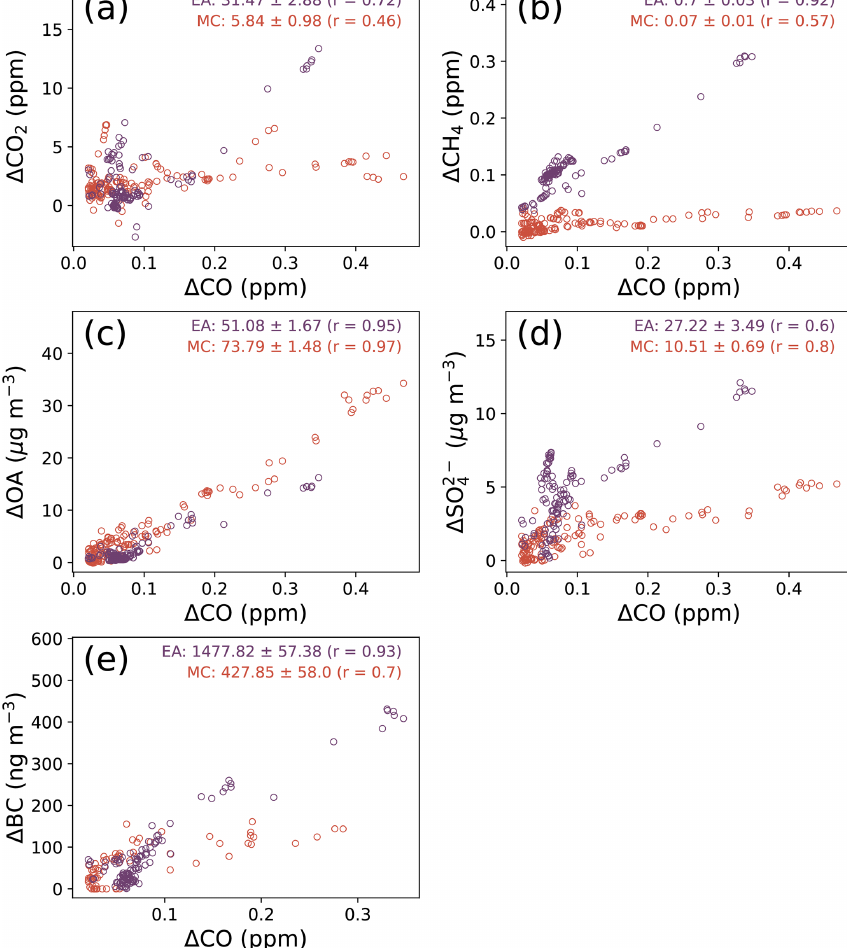
Figure 7. Linear regressions of (a) (cid:49) CO 2 /(cid:49) CO, (b) (cid:49) CH 4 /(cid:49) CO, (c) (cid:49) OA /(cid:49) CO, (d) (cid:49) SO 2 − Continent (MC; red) and East Asia (EA; purple). Annotated are species ratios (slope) per region and standard error (SE) as a measure of uncertainty (slope ± SE). Pearson’s R values are provided in parentheses. Only data with (cid:49) CO > 0.02ppm were included to better identify combustion-related ratios. Peninsular Southeast Asia and West Pacific data were not plotted due to low